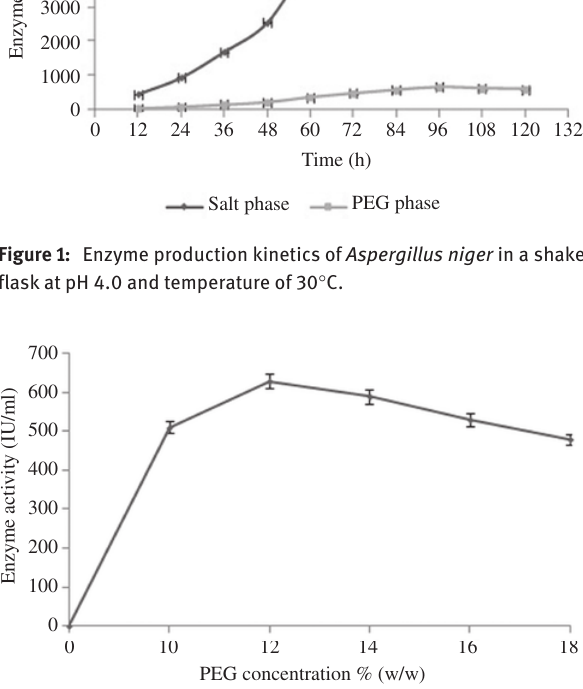
Figure 2: β -Glucosidase production at different PEG